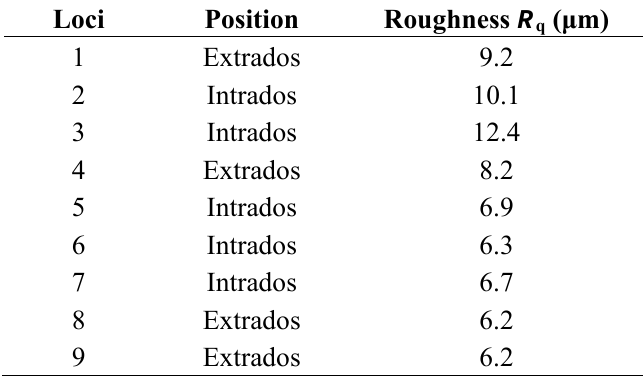
Table 1. Experimental roughness obtained for the selected points of the aircraft